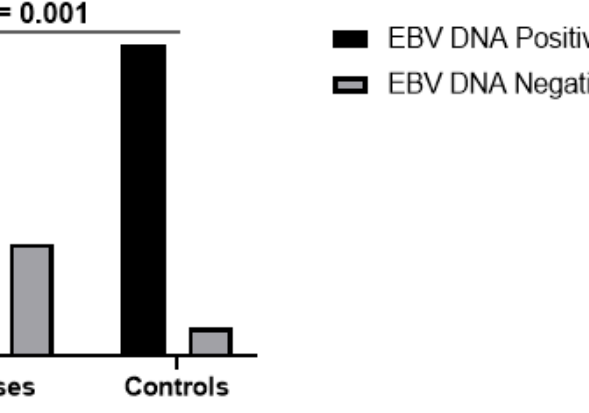
Figure 1. Graph showing frequency of EBV positivity in NPC cases and controls. Frequency of EBV positivity was significantly higher in control subjects than cases, when comparison was done using Chi-squared test of independence for contingency table ( p =